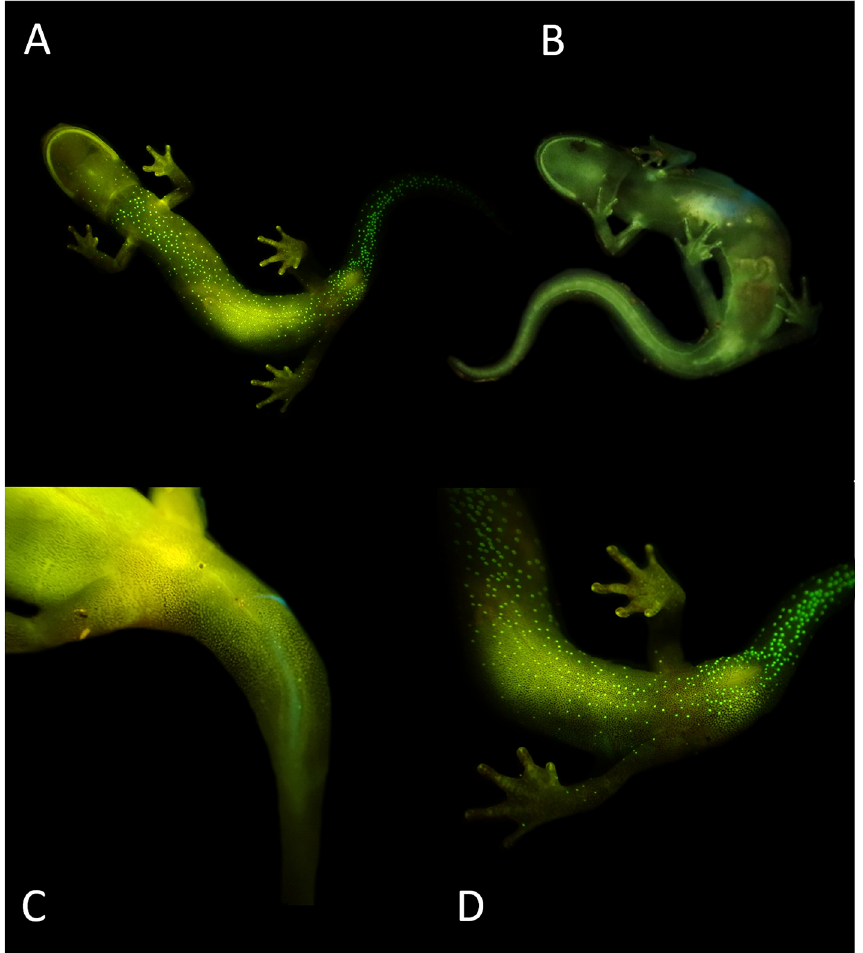
Figure 2. Photographs of P. metcalfi salamanders taken with a 500 nm longpass camera lens filter while exposed to blue excitation light. ( A ) Ventral surface of a male P. metcalfi displaying biofluorescent speckling. ( B ) Ventral surface of a female P. metcalfi lacking biofluorescent speckling. ( C ) Cloacal region of a female with minimal speckling and the ( D ) cloacal region of a male displaying biofluorescent